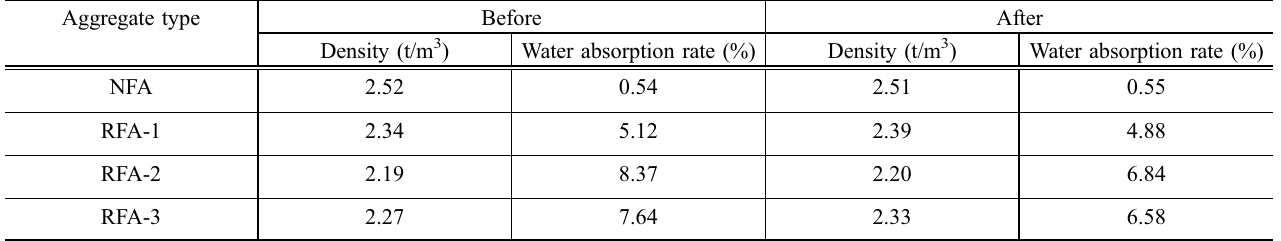
Table 10 Changes in the specific gravity and absorption rate of fine aggregates.